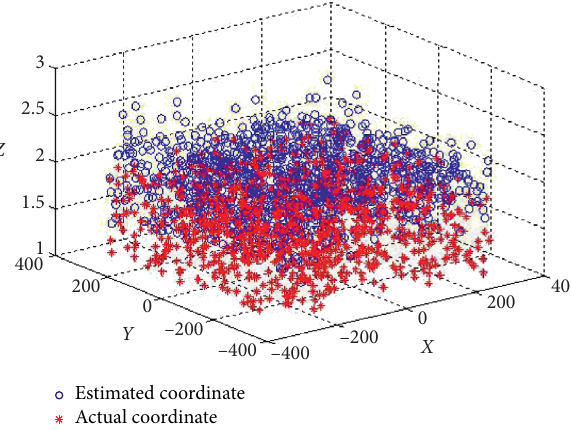
Figure 6: 3D location results under Test data 2.